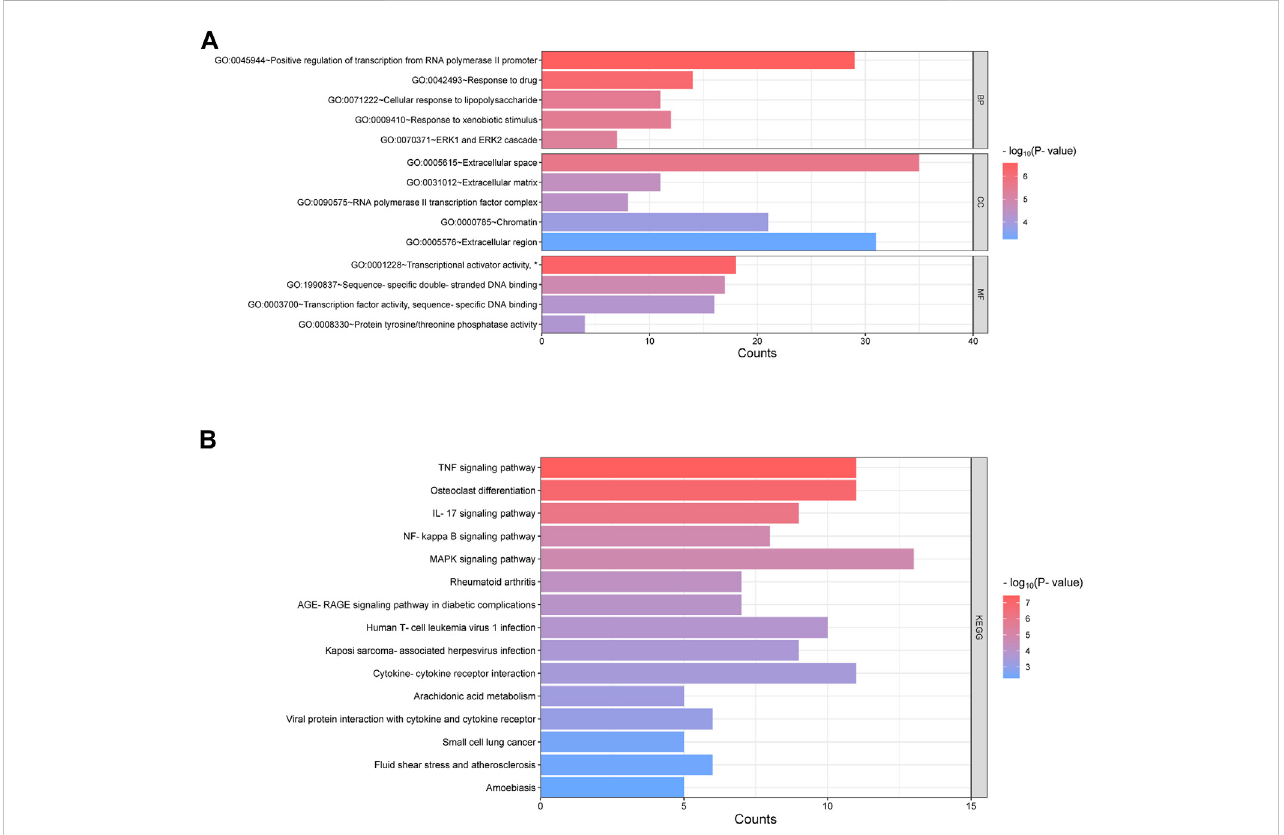
FIGURE 3 Enrichment of GO and KEGG of 161 common DEGs. (A) Go annotation categories of 161 common DEGs including top 5 of BP, top 5 of CC and top 4 of MF. The horizontal axis represents counts of enriched genes. (B) Top 15 KEGG pathway categories after enrichment analysis of 161 common DEGs. The horizontal axis represents counts of enriched genes. GO = gene ontology; BP = biological processes; CC = cellular components; MF = molecular function; KEGG=KyotoEncyclopediaofGenesandGenomes.(*represents “ RNApolymeraseIItranscriptionregulatoryregionsequence-speci fi cbinding ” ,which was hided due to the